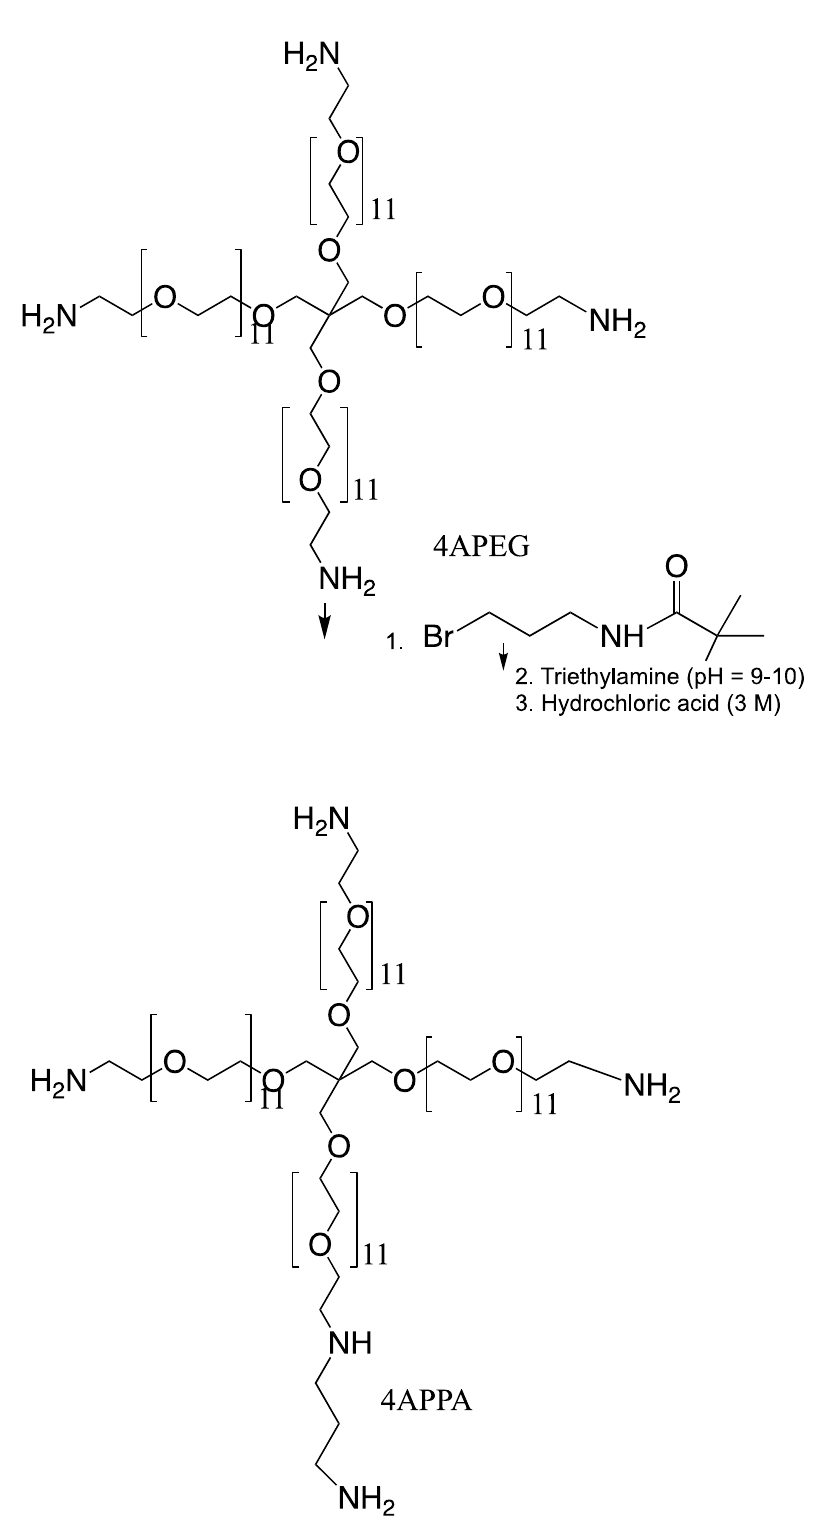
Figure 1. Synthesis of 4APPA.